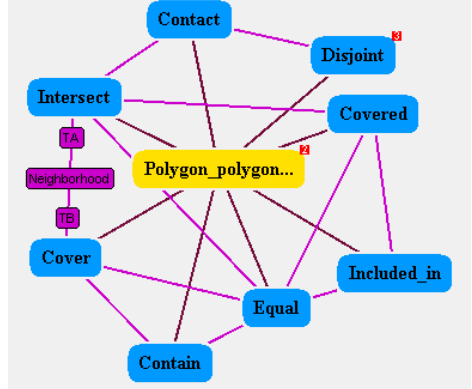
Figure 4. Topic map of polygon-polygon topological relations